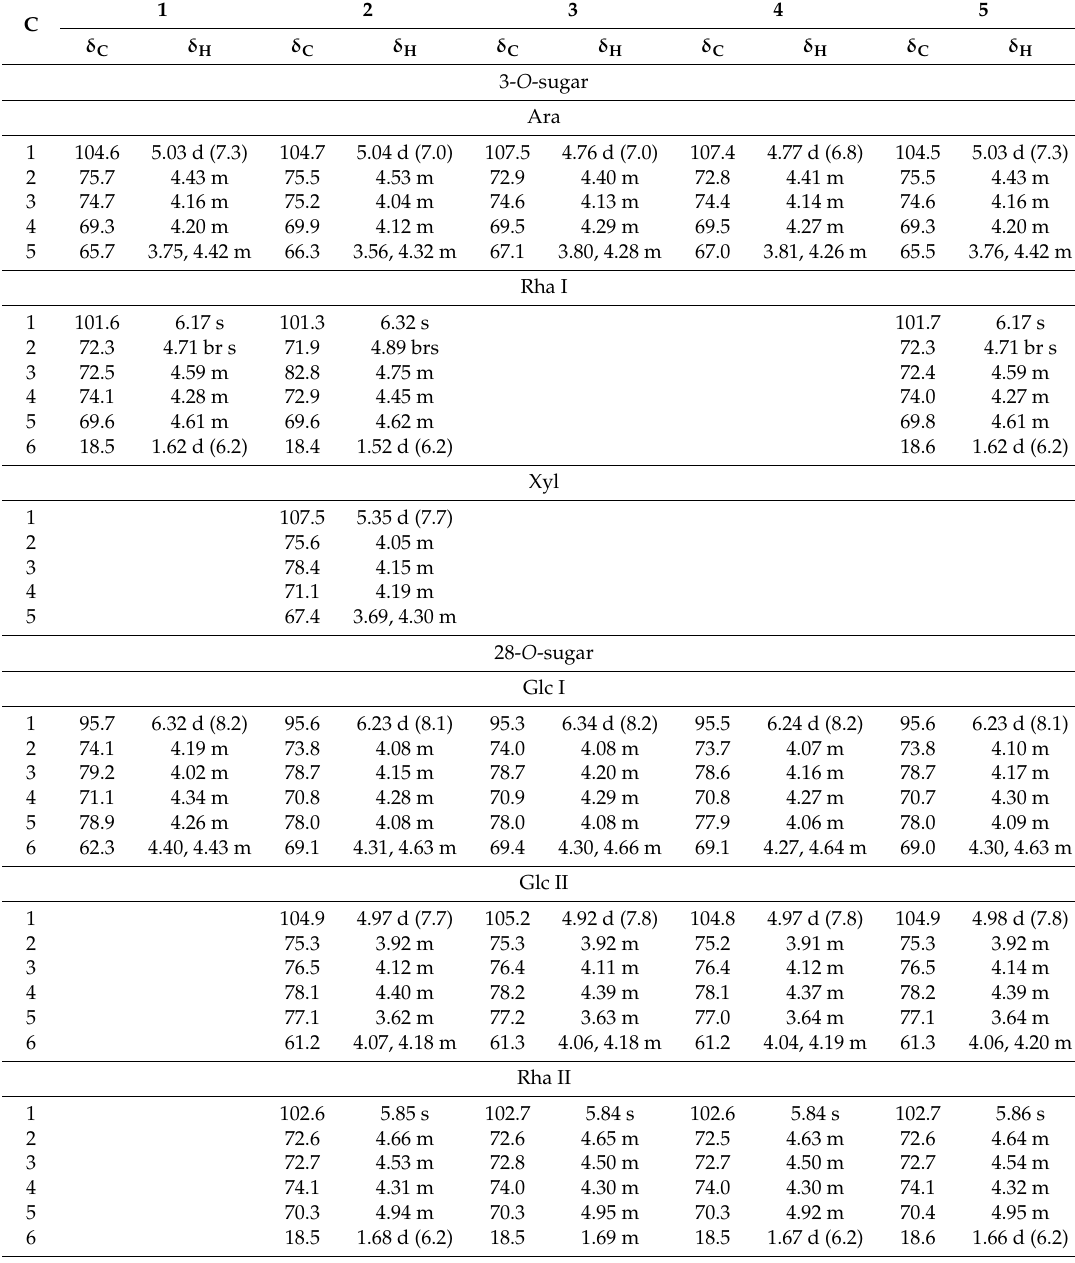
Table 2. 1 H- (500 MHz) and 13 C-NMR (125 MHz) data for the sugar moieties of 1 – 5 in pyridine- d 5